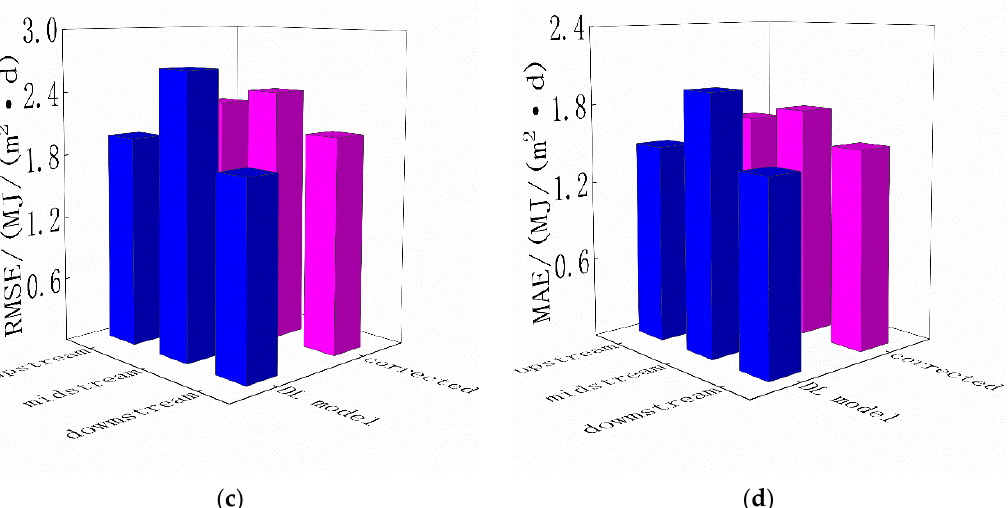
Figure 3. ( a ) The determination coefficient R 2 values of the prediction results of the corrected Å-P parameters and the DL model in the upstream, midstream and downstream of the Yellow River Basin; ( b ) The mean square error MSE values of the prediction results of the corrected Å-P parameters and the DL model in the upstream, midstream and downstream of the Yellow River Basin; ( c ) The rooted mean square error RMSE values of the prediction results of the corrected Å-P parameters and the DL model in the upstream, midstream and downstream of the Yellow River Basin; ( d ) The mean absolute error MAE values of the prediction results of the corrected Å-P parameters and the DL model in the upstream, midstream and downstream of the Yellow River Basin.